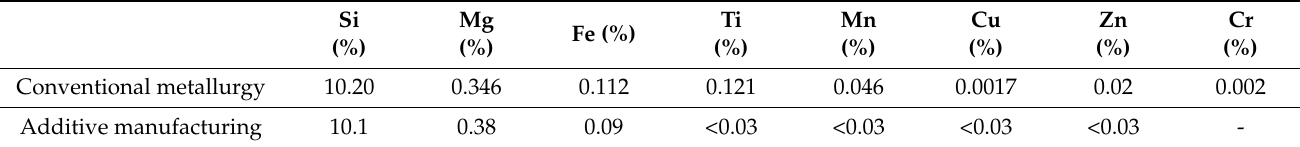
Table 1. Chemical composition of the analysed